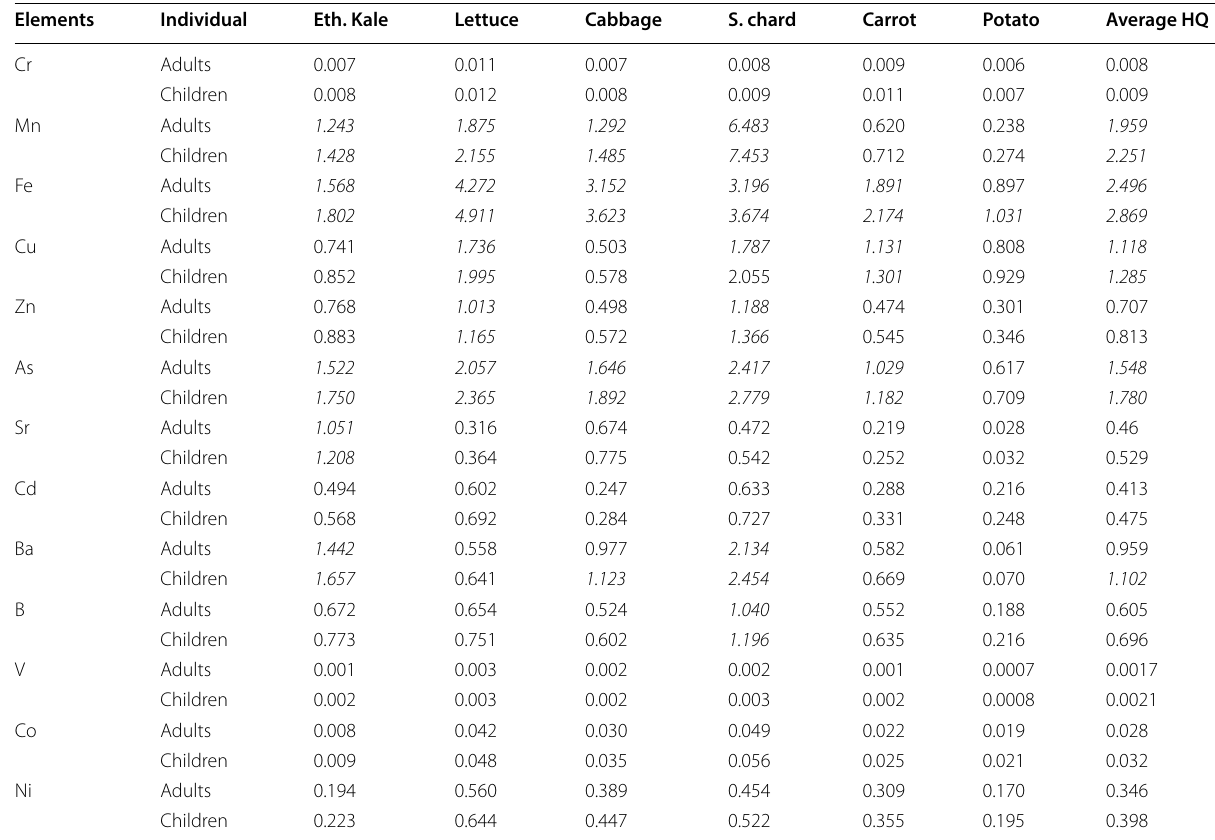
Table 6 Mean HQ values of PTEs via intake of vegetables from wastewater irrigated farms